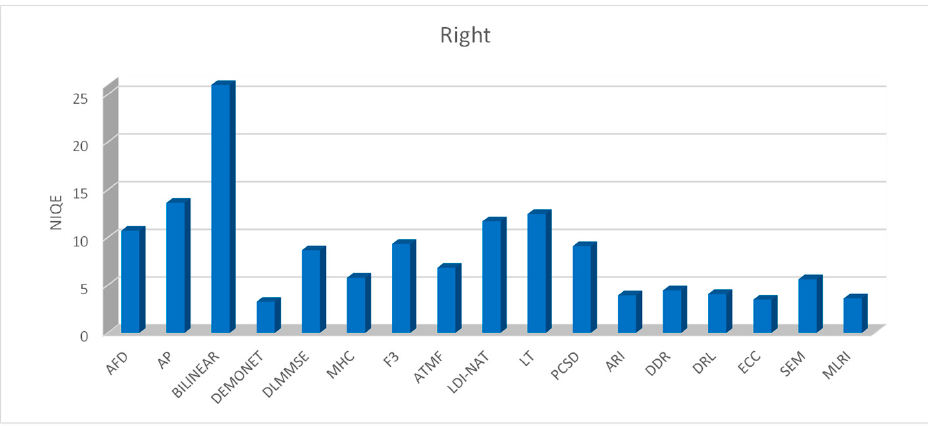
Figure 10. Averaged NIQE scores of different bands using all methods for right images.